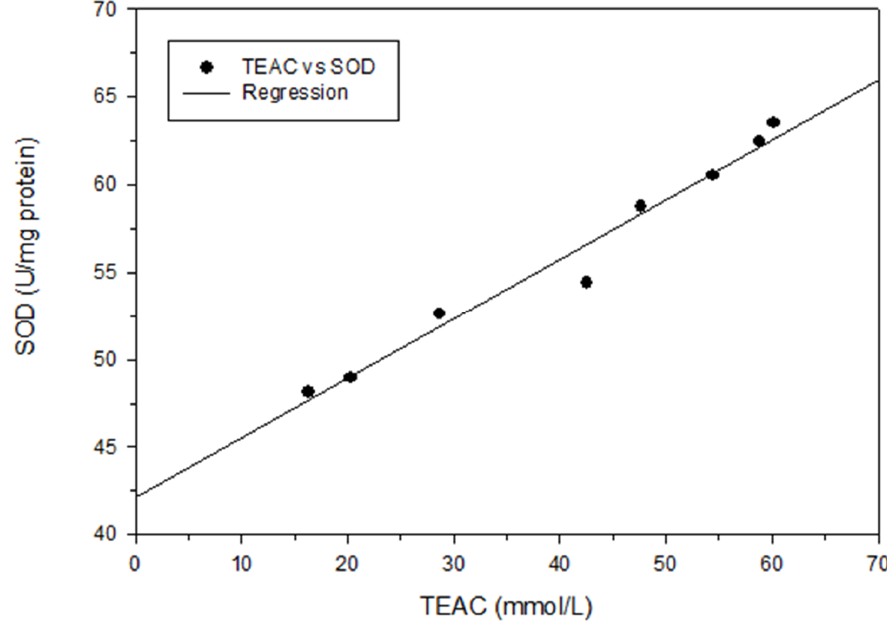
Figure 5. Correlation between TEAC (mmol/L) and SOD (U/mg protein). Each test was performed in triplicate, and results are expressed as the average of three measurements ± standard deviation. The scale of error bar is too small to be